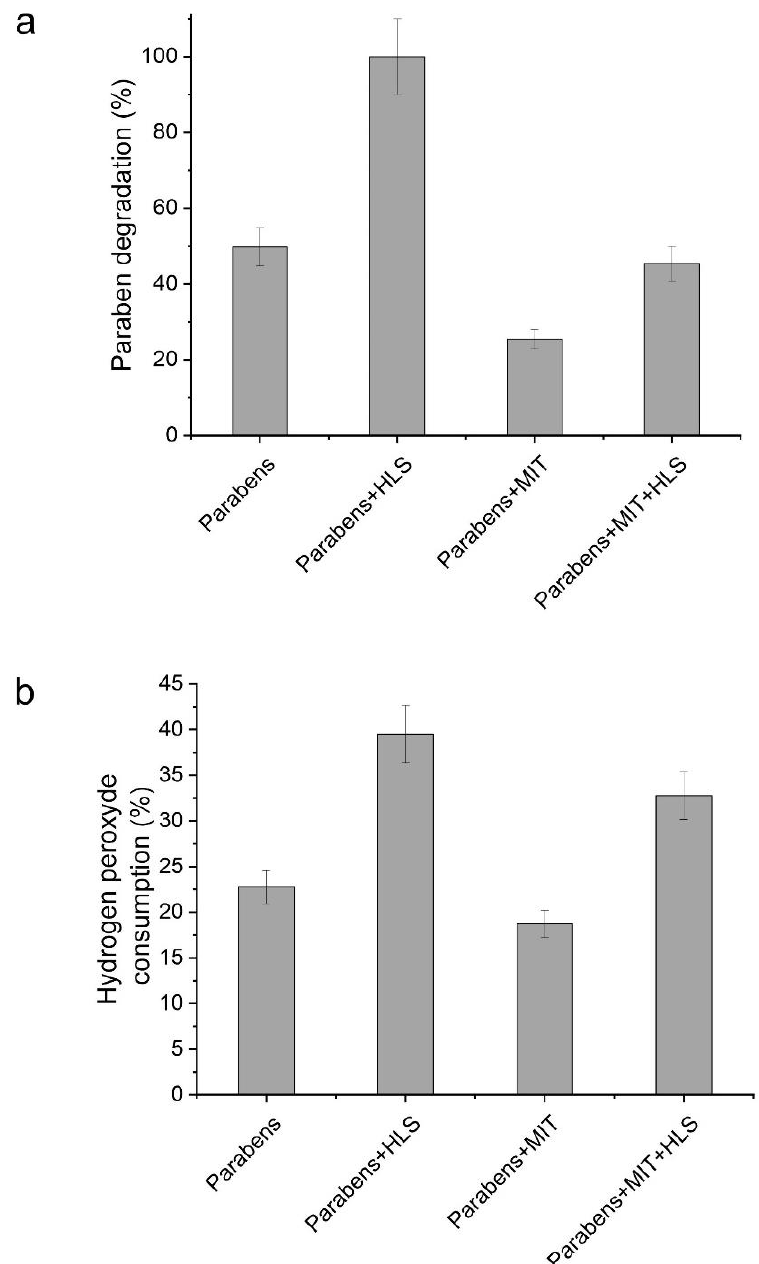
Figure 6. ( a ) Percentage degradation of parabens after two hours in the presence and absence of MIT and HLS; ( b ) hydrogen peroxide consumption after two hours of the degradation of parabens in the presence and absence of MIT and